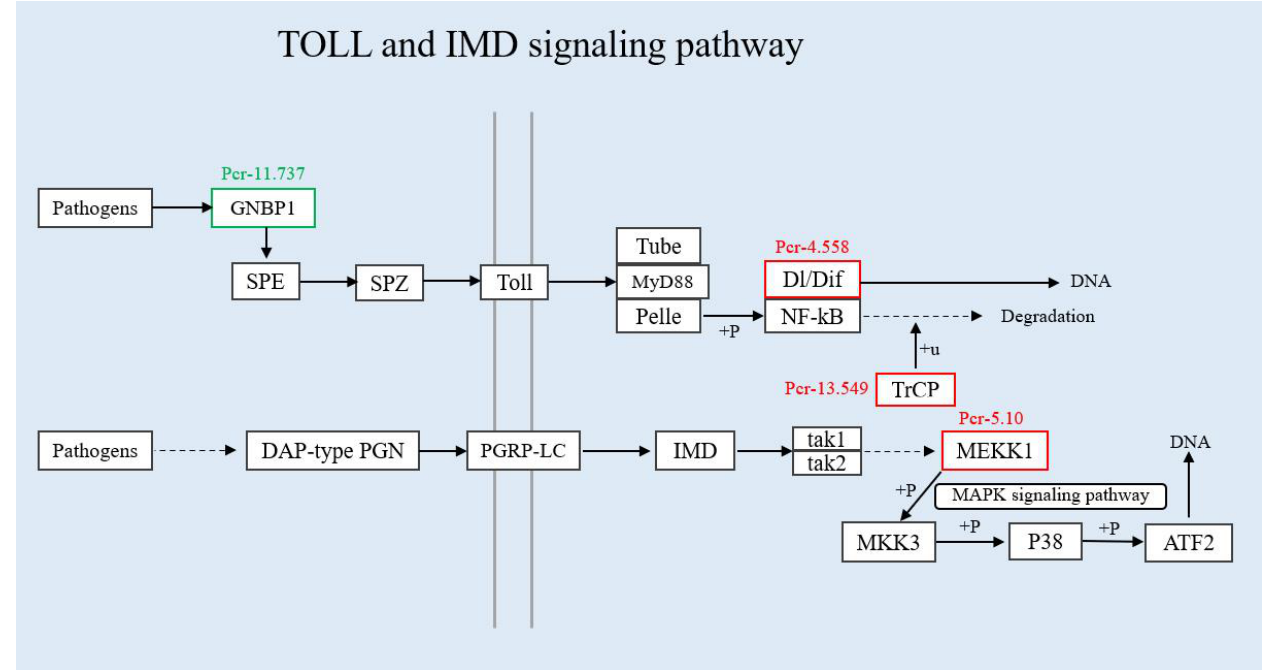
Figure 8. DEPs involved in the TOLL and IMD signaling pathways. The two vertical gray lines on the left represent the cell membrane, the solid line is the activation effect, and the dotted line is the indirect effect.